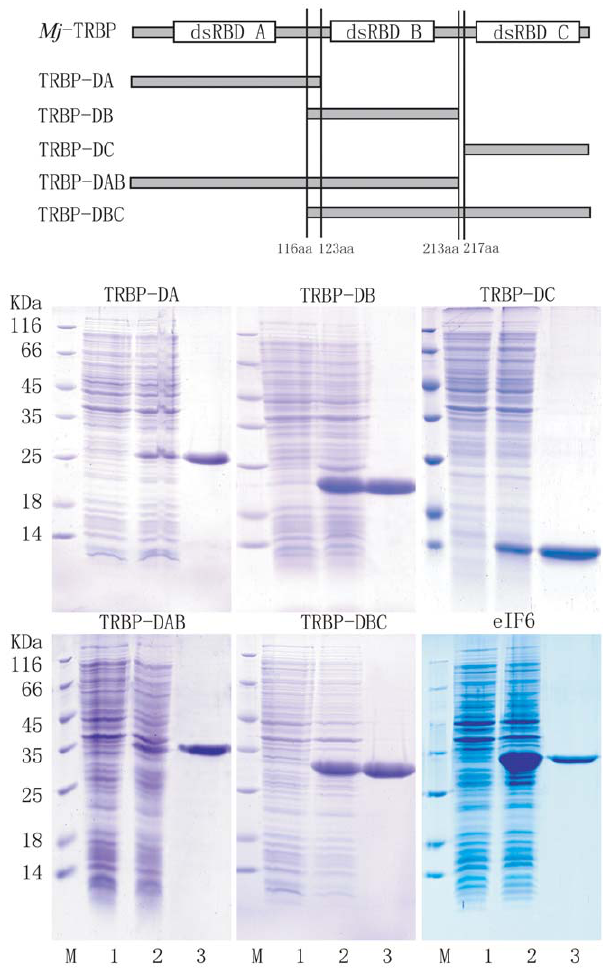
Figure 1. Scheme of the dsRBDs of Mj -TRBP and the SDS-PAGE analysis of recombinant dsRBDs of M j-TRBP and Fc -eIF6 expressed in E.coli . The N-terminal (first), middle (second), and C- terminal (third) dsRBDs were denoted as dsRBD A, dsRBD B, and dsRBD C, respectively. The recombinant protein TRBP-DA, TRBP-DB, TRBP-DC, TRBP-DAB, and TRBP-DBC contain dsRBD A, dsRBD B, dsRBD C, dsRBD A and dsRBD B, and dsRBD B and dsRBD C,respectively. Lane M, molecular mass marker; lane 1, total protein obtained from E. coli ; lane 2, total protein obtained from expressing strains induced by IPTG; lane 3, recombinant proteins purified by His-Bind resin chromatography.